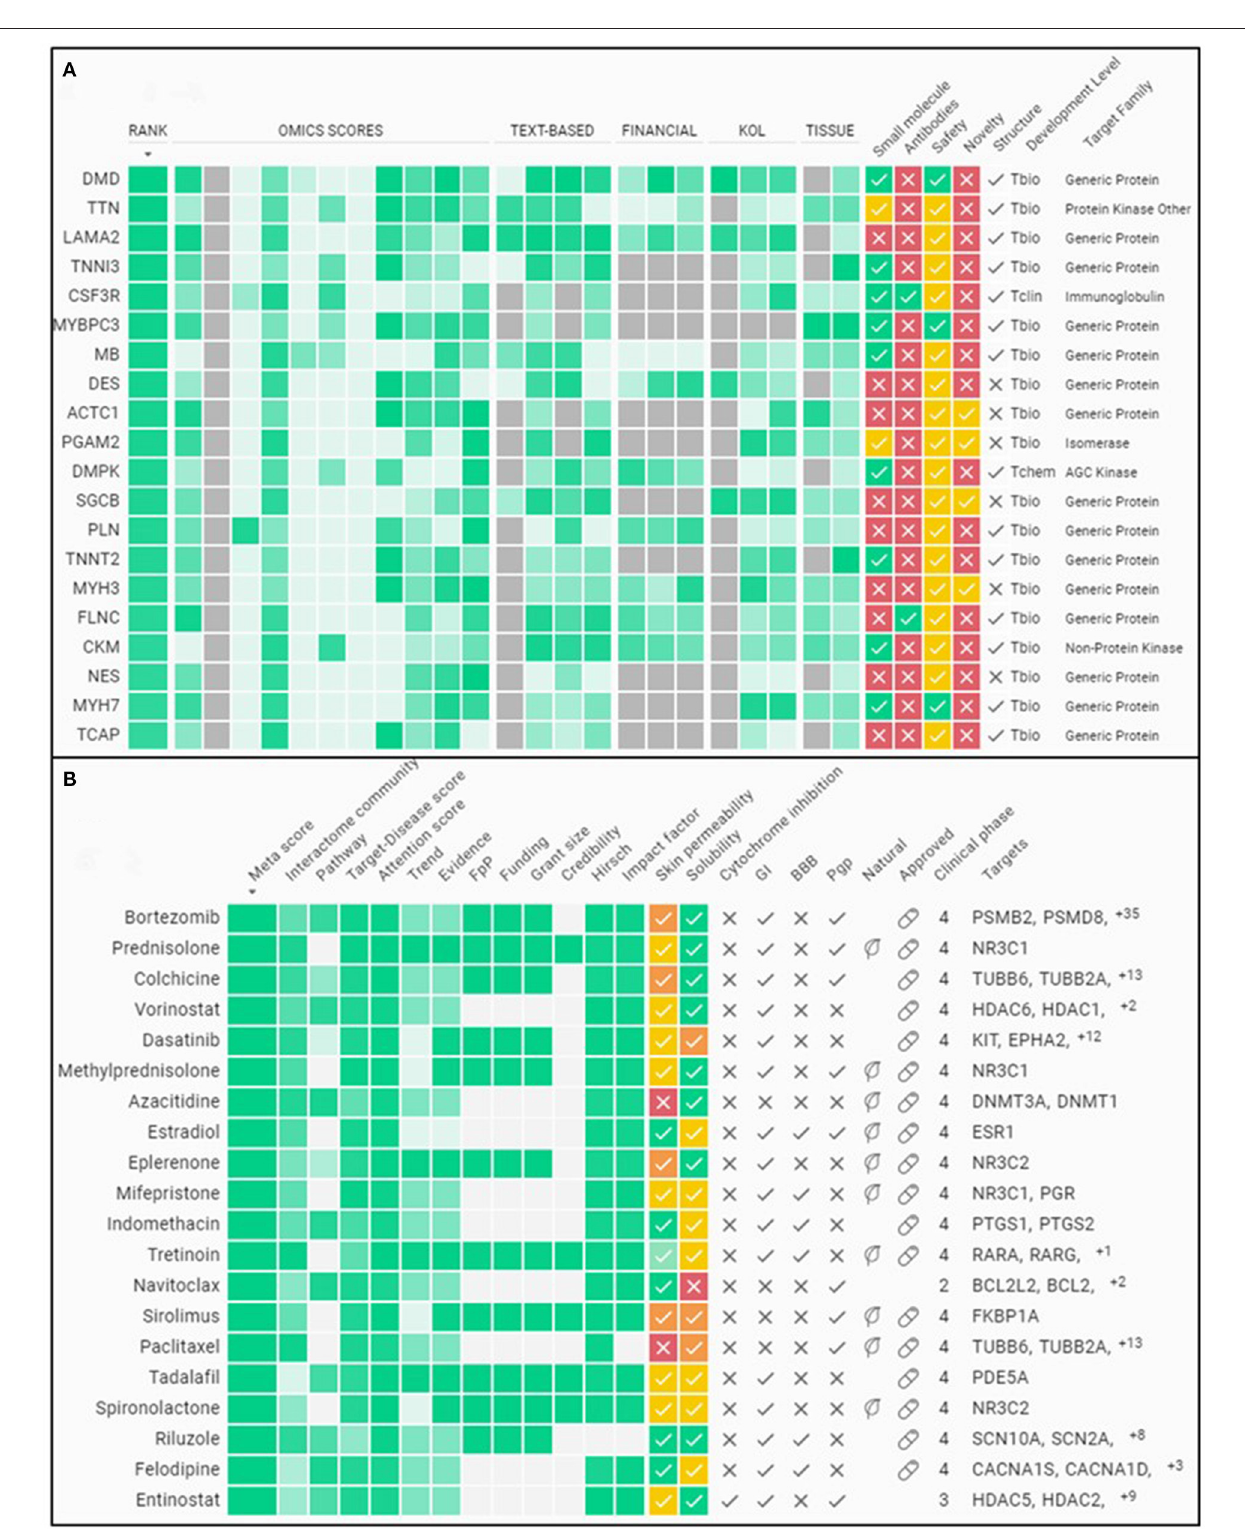
Frontiers in Cardiovascular Medicine |